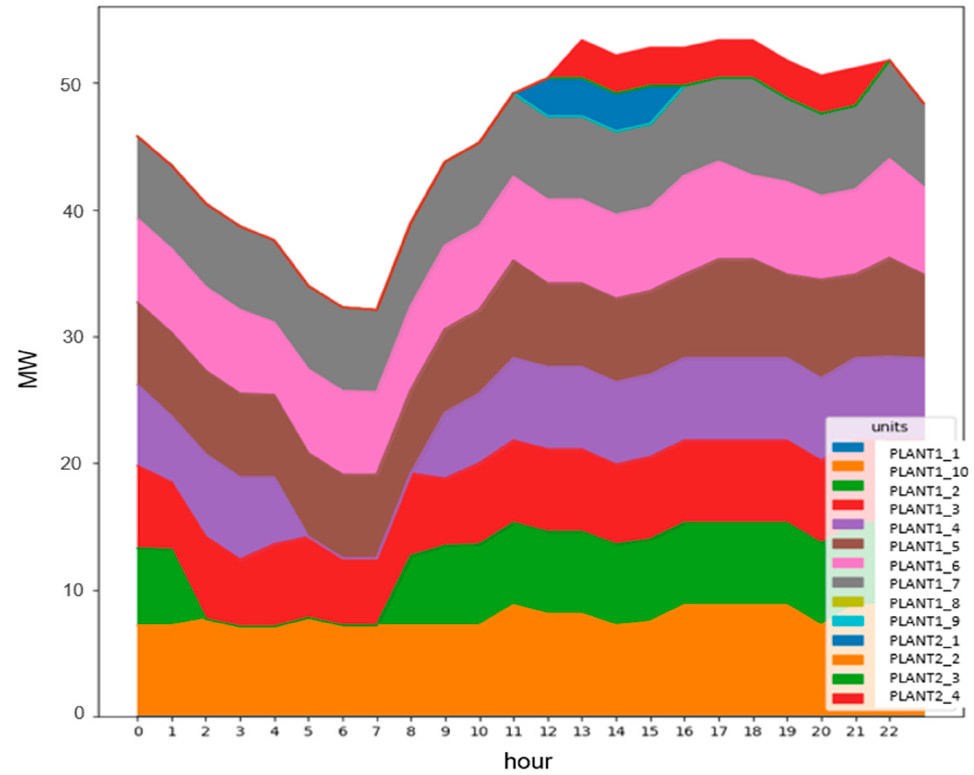
Figure 9. Case 2 hourly power generation of each fuel generator.